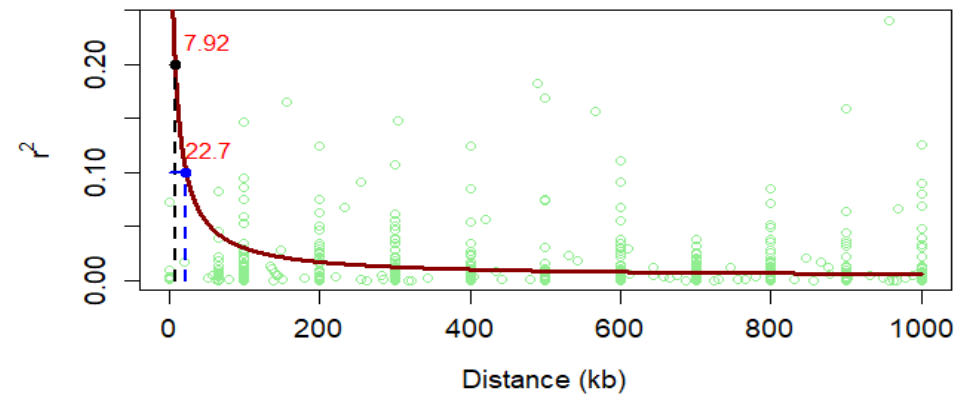
Figure 2. Linkage disequilibrium (LD) plot representing the average genome-wide LD decay in the panels with genome-wide markers. The values on the y -axis represent the squared correlation coefficient, r 2 , and the x -axis represents the physical distance in kb.